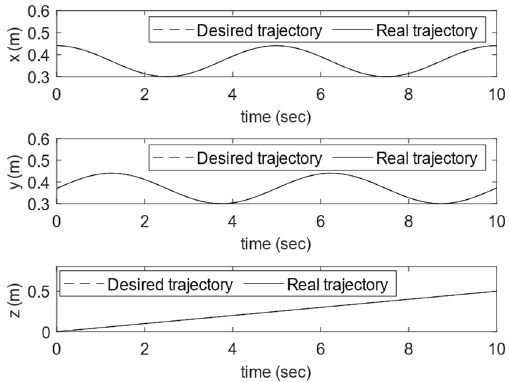
Figure 7. 3D position behavior of UR5 in the presence of the proposed controller.